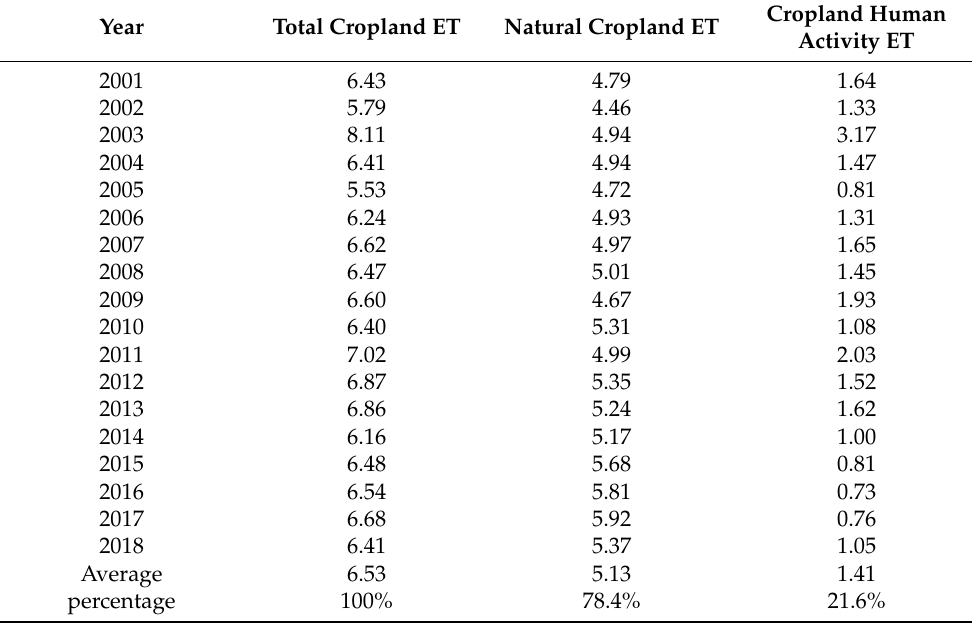
Table 2. Agricultural water consumption in the YD River Basin from 2001 to 2018 (10 9 m 3 ). Year Total Cropland ET Natural Cropland ET